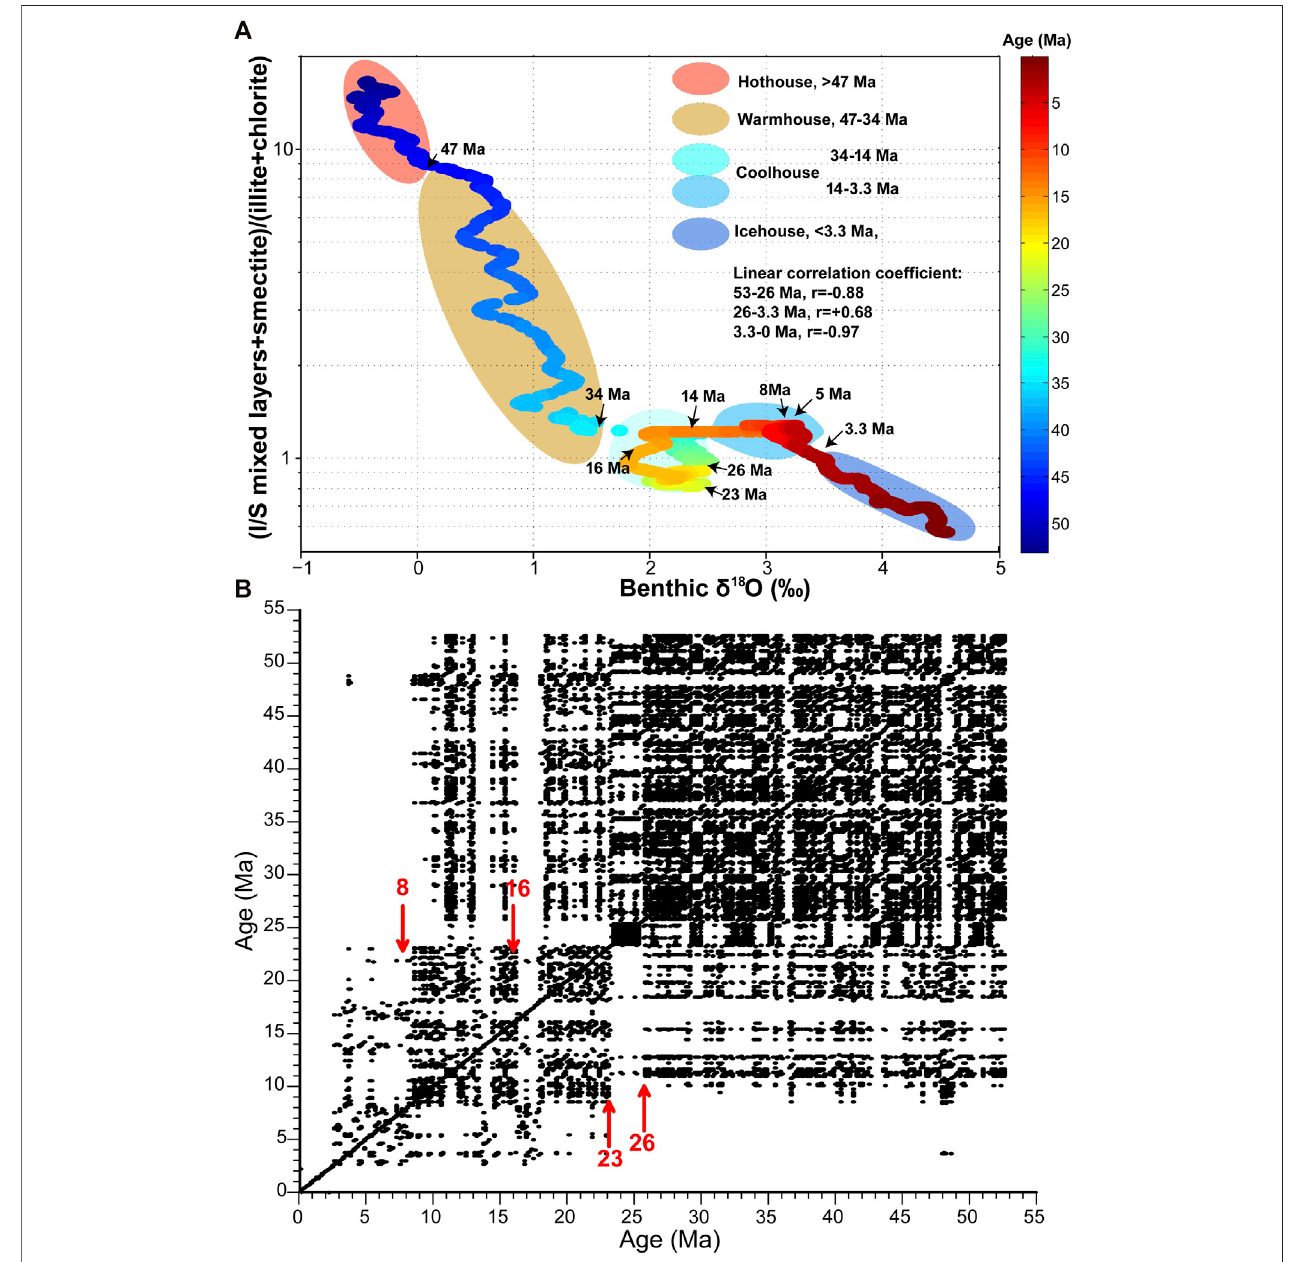
FIGURE 3 | Transitions of silicate weathering intensity in the NE Tibetan Plateau (A) Biplot of the (I/S mixed layer + smectite)/(illite + chlorite) ratio (using the LOESS fi tting data shown in Figure 1 ) versus benthic oxygen data (Westerhold et al., 2020), illustrating the relationship between the two signals since 53 Ma. The four climate states (Hothouse, Warmhouse, Coolhouse, and Icehouse) are from Westerhold et al. (2020). Note the interruption of the pronounced negative correlation between the two signals during the Coolhouse state after ~26 – 23 Ma (B) Recurrence plots of (I/S mixed layer + smectite)/(illite + chlorite) ratio, showing patterns of climate changeandmajor systemtransitions. Thedarkshadingindicatesintervals withsimilar weatheringdynamics,and theunshaded areasindicateintervals withnocommon dynamics. The three major transitions are indicated by red arrows.